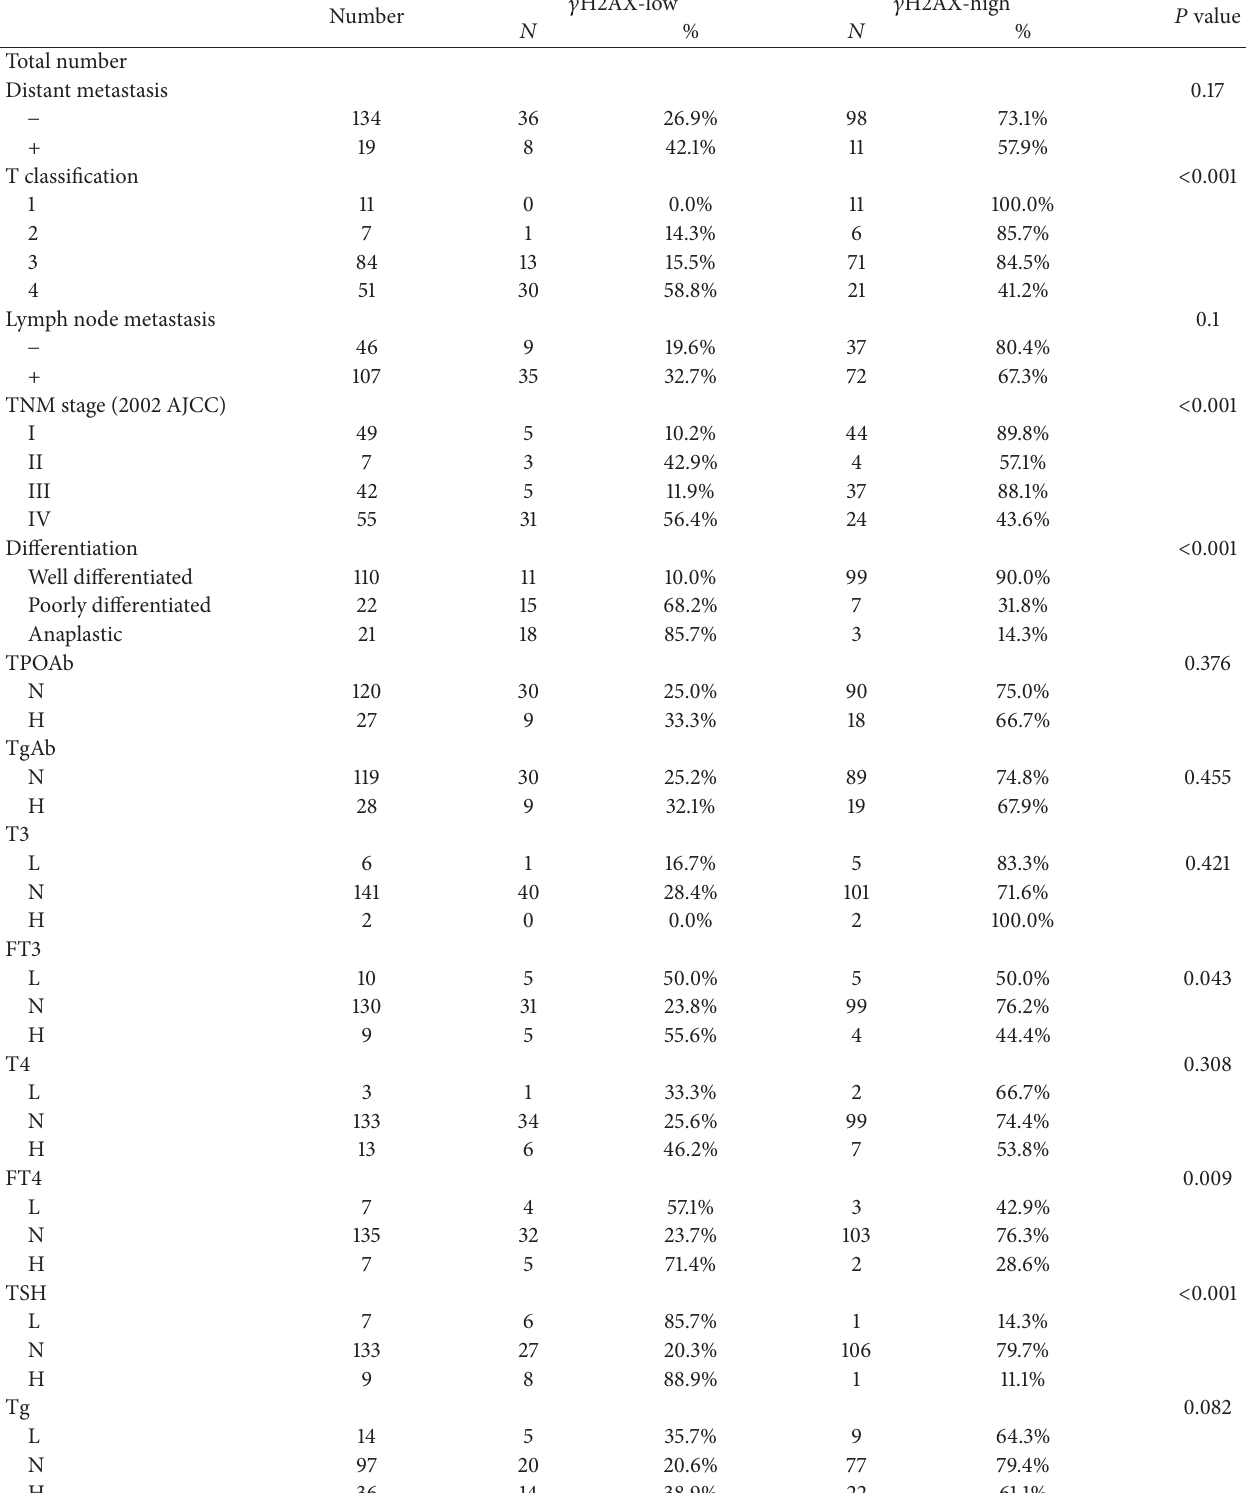
Table 3: Association between 𝛾 H2AX expression and clinicopathological